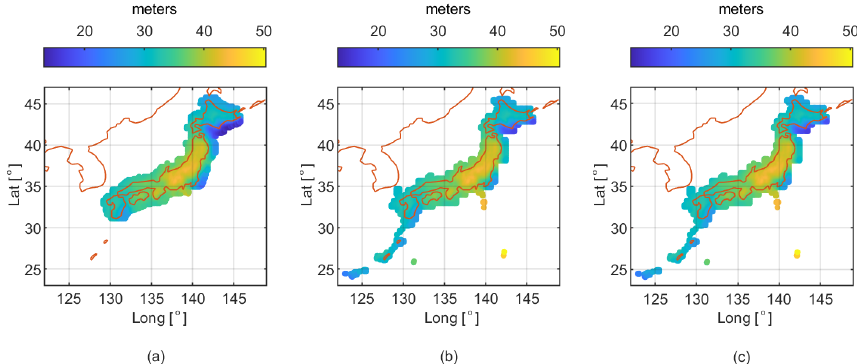
Figure 6. Evolution of Japanese geoid models over time. The three panels represent the geoid undulation with respect to the reference ellipsoid of (a) GSIGEO96, (b) GSIGEO2000, and (c) GSIGEO2011.